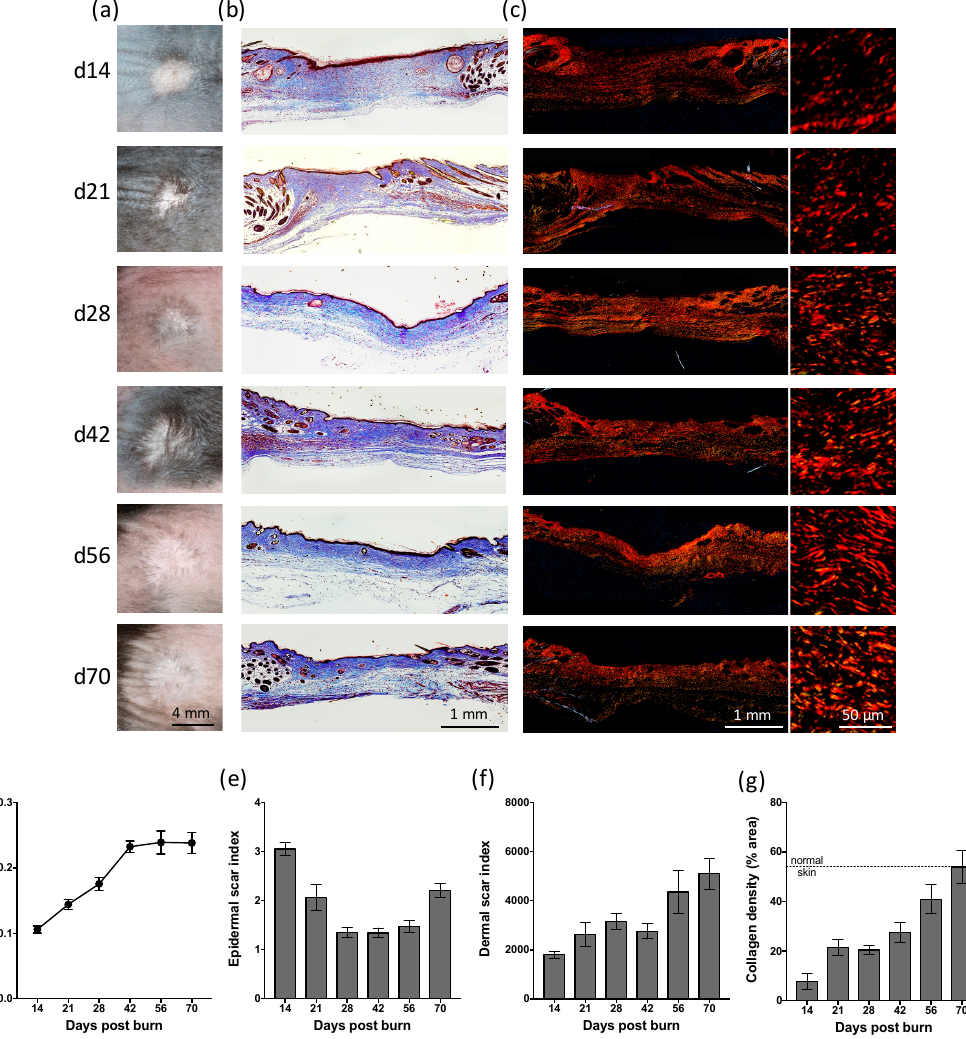
Figure 3. Heated metal rod burns result in a persistent scar. ( a ) Photographs and images of ( b ) MSB-stained and ( c ) picrosirius red-stained sections of skin scars at the indicated day post-thermal burn. Collagen deposition within the scars is shown at higher magnification in the right panel. Scale is as indicated. ( d ) Scar area is shown as a change in the percentage of the area over-time. ( e ) Epidermal scar index is shown as the change in epidermal width within the scar relative to adjacent skin over-time. ( f ) Dermal scar index is shown as the change in the dermal scar area relative to the average scar width over-time. ( g ) Collagen density is shown as the change in the percentage of the area of collagen staining over-time. Data represents the mean ± SEM, n = 8.